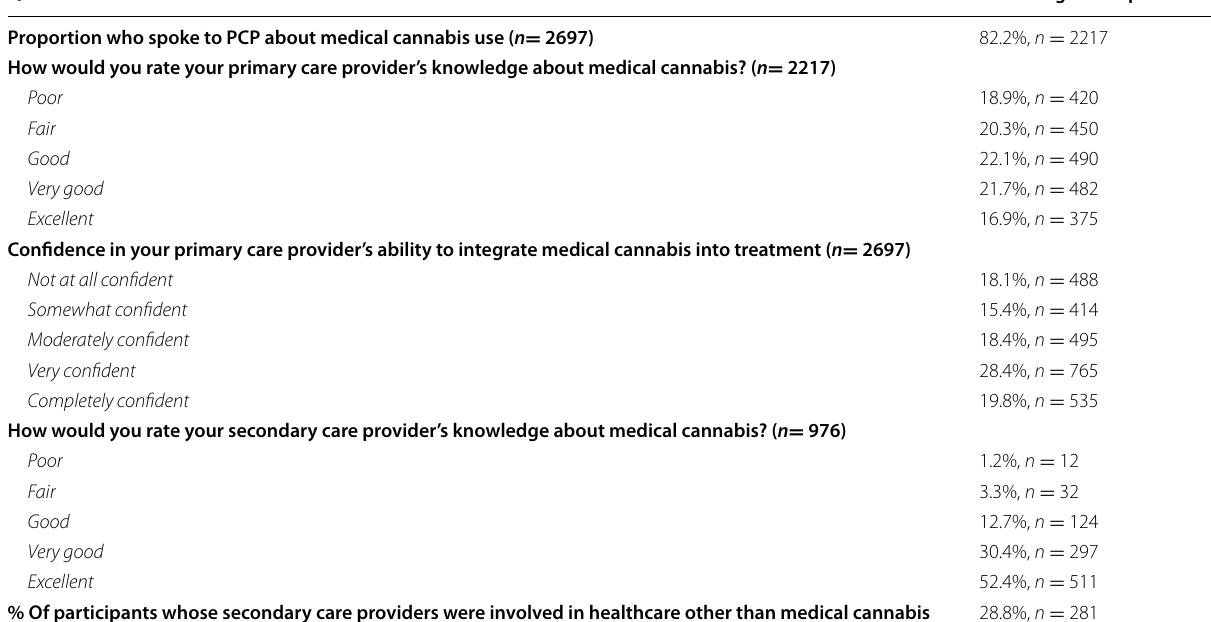
Table 2 Perceptions of primary care provider (PCP) knowledge and confidence in ability to integrate medical cannabis into treatment